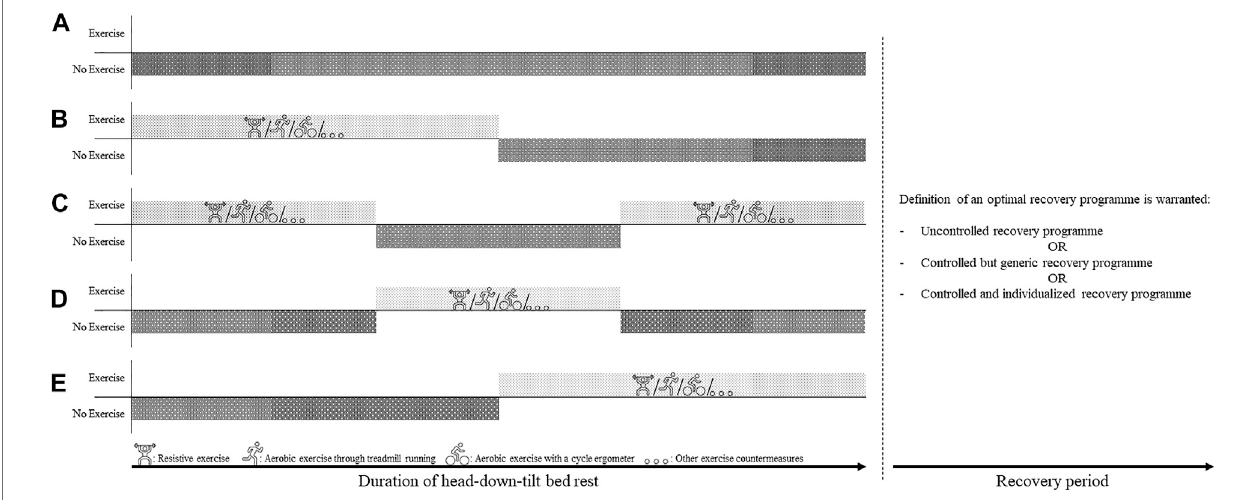
FIGURE 6 | Illustration of possible implementations of Exercise Holidays and possible recovery programme modalities for future head-down-tilt bed rest campaigns. (A) No Exercise: The generic ‘ no exercise ’ control group wherein participants do not perform any exercise countermeasures through the duration of the bed rest campaign (B) Exercise First: Participants start the bed rest campaign with an exercise countermeasure programme, followed by a period of no exercise until theendofthecampaign (C)Exercise — Rest — Exercise: Participantsstartandendthebedrestcampaignwithaperiodofexercisecountermeasures,separated byaperiodofexerciseholidays (D) Rest — Exercise — Rest: Participantsstartandendthebedrestcampaignwithoutanyexercise(i.e.,exerciseholiday),separatedby a period of exercise countermeasures (E) Rest First: Participants start the bed rest campaign with an exercise holiday, followed by a period of performing exercise countermeasuresuntiltheendofthecampaign.Allofthedifferentiterationsofbedrestcampaignsdescribedabovecanbecombinedwithdifferentrecoveryprogramme modalities during post-bed rest period: Uncontrolled recovery programme: participants are not subjected to a controlled recovery programme. - Controlled but generic recovery programme: all participants complete the same recovery programme, not adapted to the personal needs of the participant. - Controlled and individualized